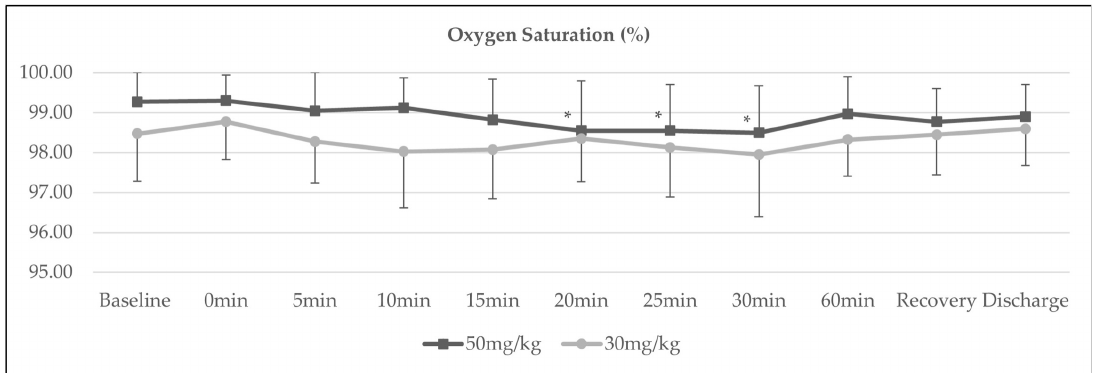
Figure 2. Trend of oxygen saturation, p = 0.040; * p < 0.05 (intragroup comparison with baseline MAP).